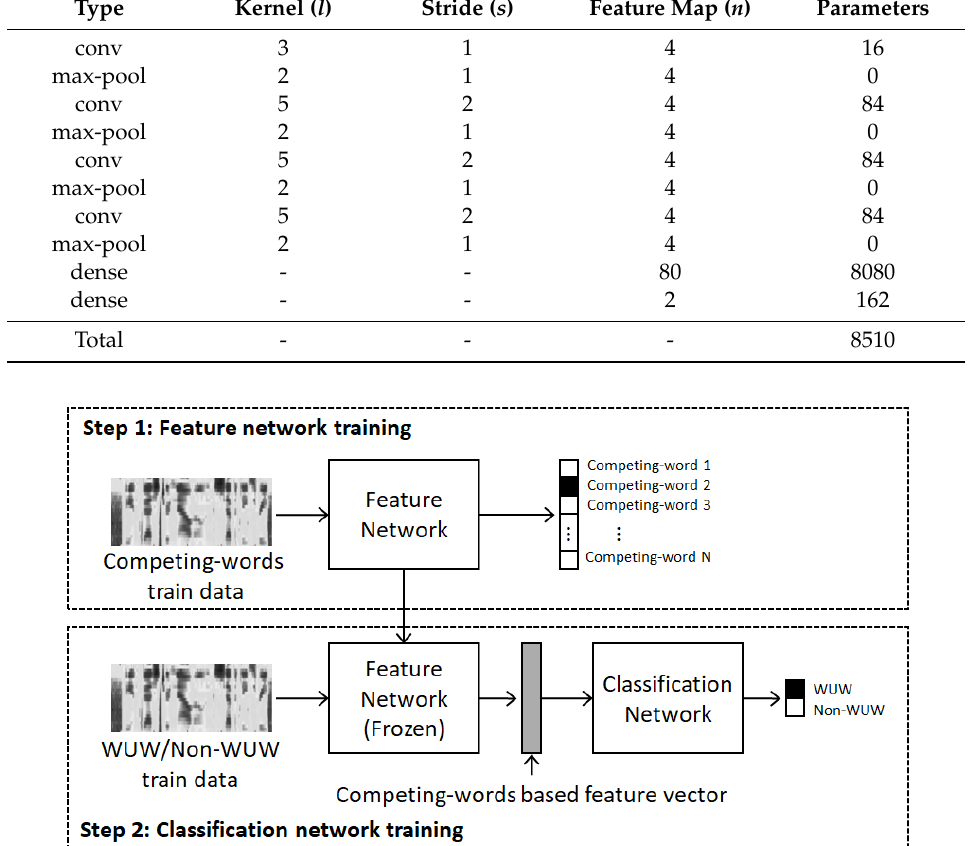
Figure 2. Block diagram of the proposed WUW recognition system.